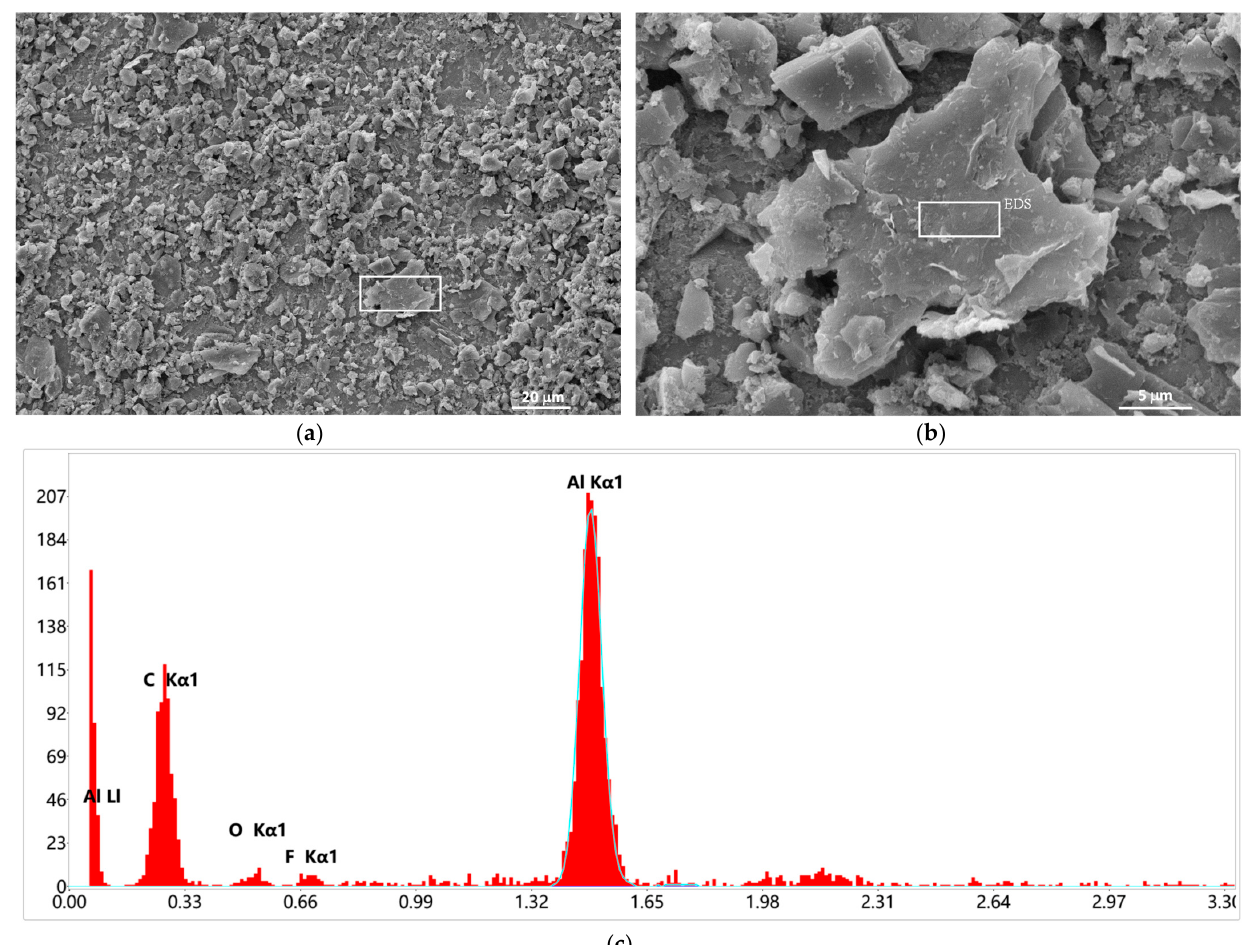
Figure 7. ( a , b ) SEM image of AC electrode after overcharging, and ( c ) EDS